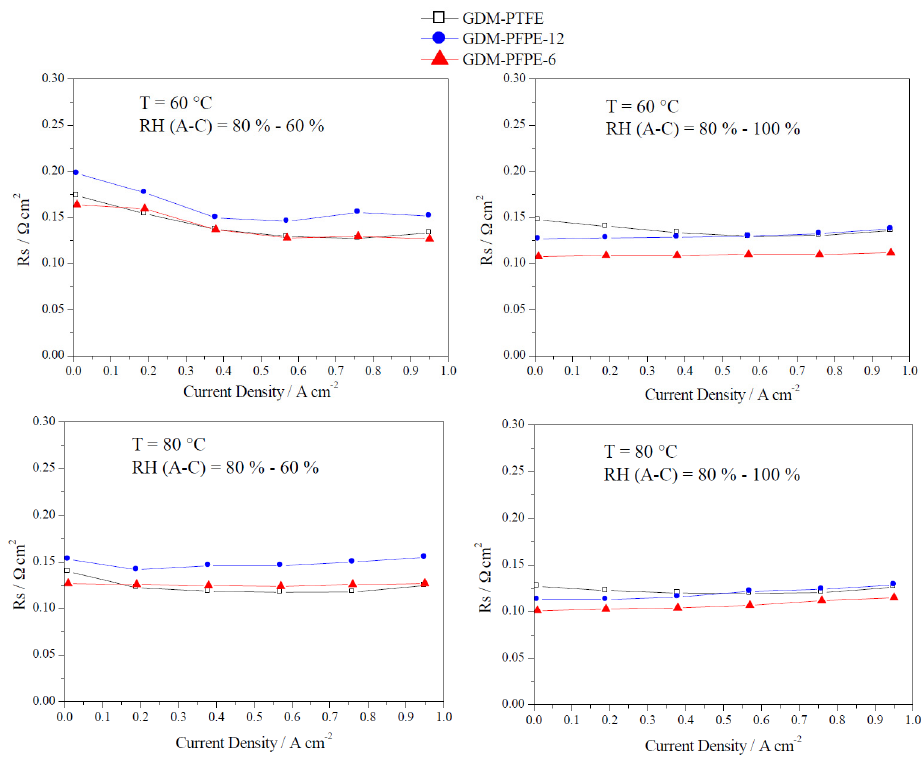
Figure 6. Ohmic resistance trend as a function of current density: fitting results comparisons at different operating conditions.